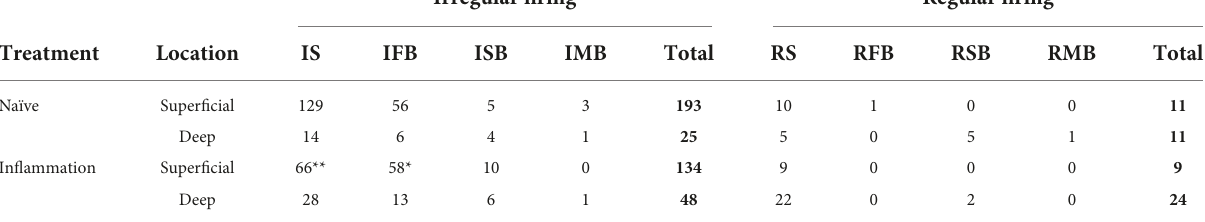
TABLE 1 Numbers of neurons recorded per treatment, class and depth.